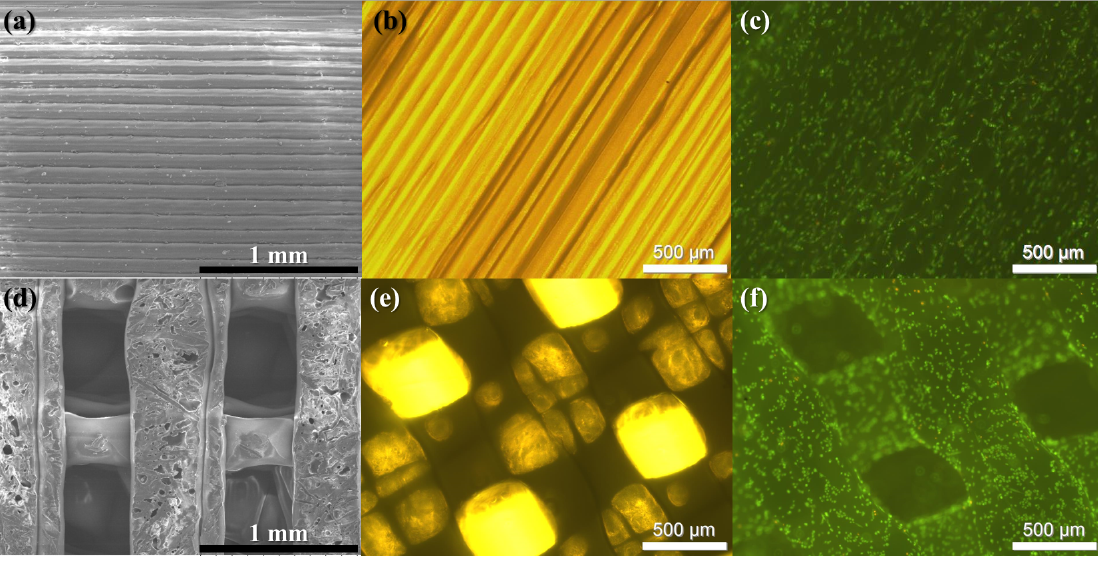
Figure 9. The SEM ( a , d ), light ( b , e ) and fluorescence microscope images ( c , f ) of the 3D printed scaffolds and myogenic cells grown on them: ( top ) 2.5D full-filled; ( bottom ) 3D microporous); in ( c , f ), cells are grown for 24 h and stained by an acridine orange-ethidium bromide mixture. Living cells are stained green, and dead cells are stained orange.